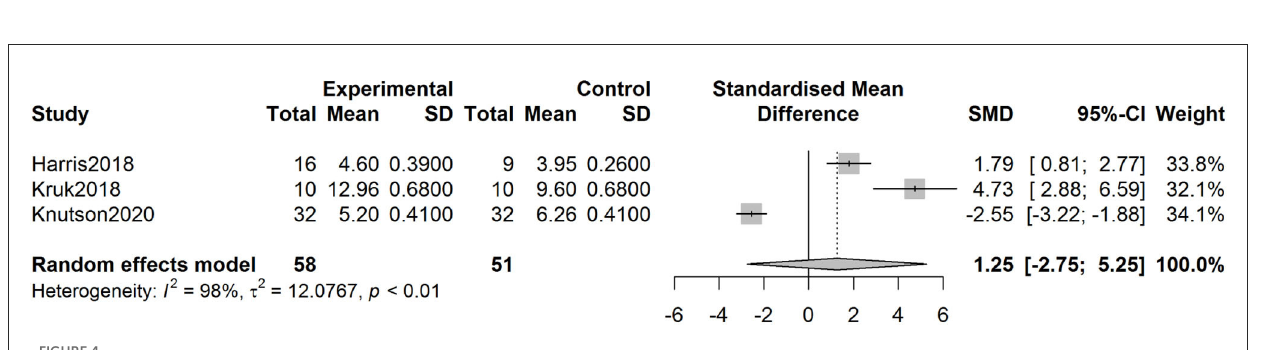
FIGURE4 Forest plots of IMF score in the vitamin A and control